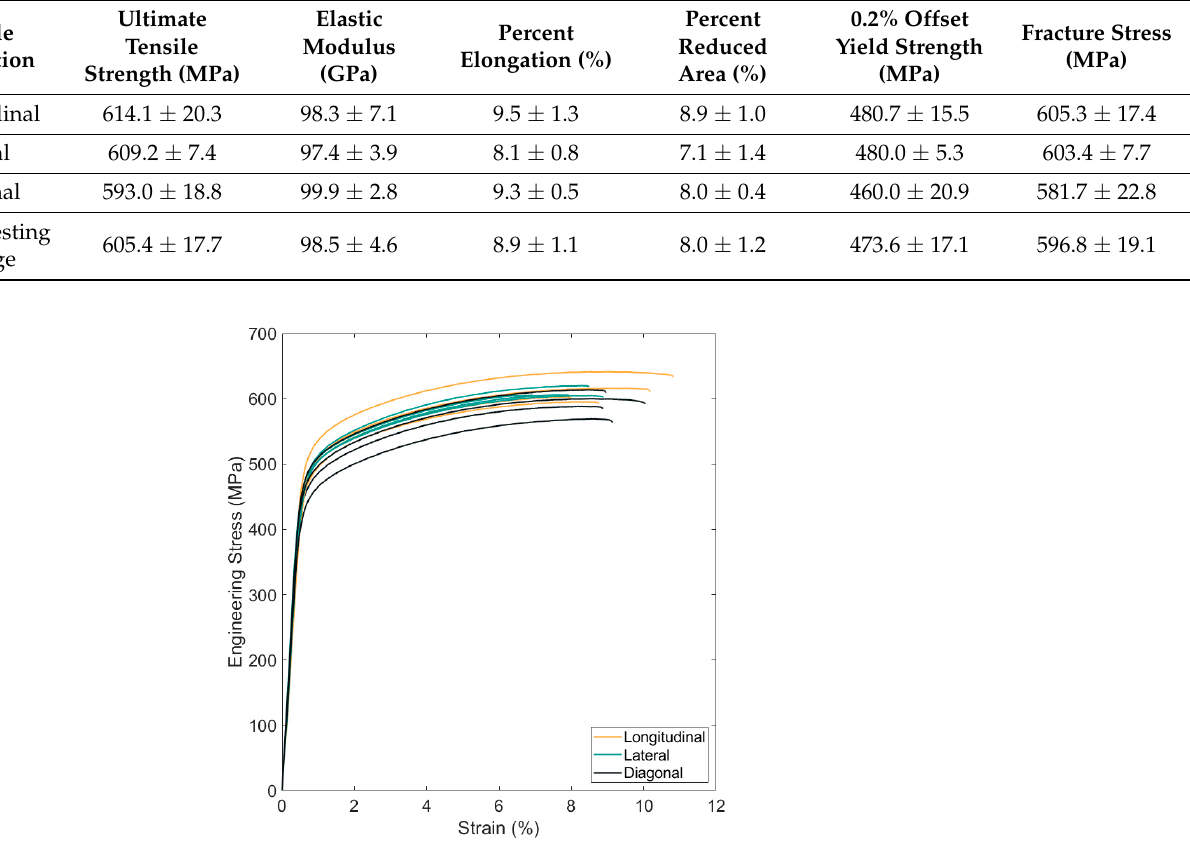
Figure 7. Directionally oriented tensile testing results for the AM Ti–TiB material, presented in the form of engineering stress versus percent strain.